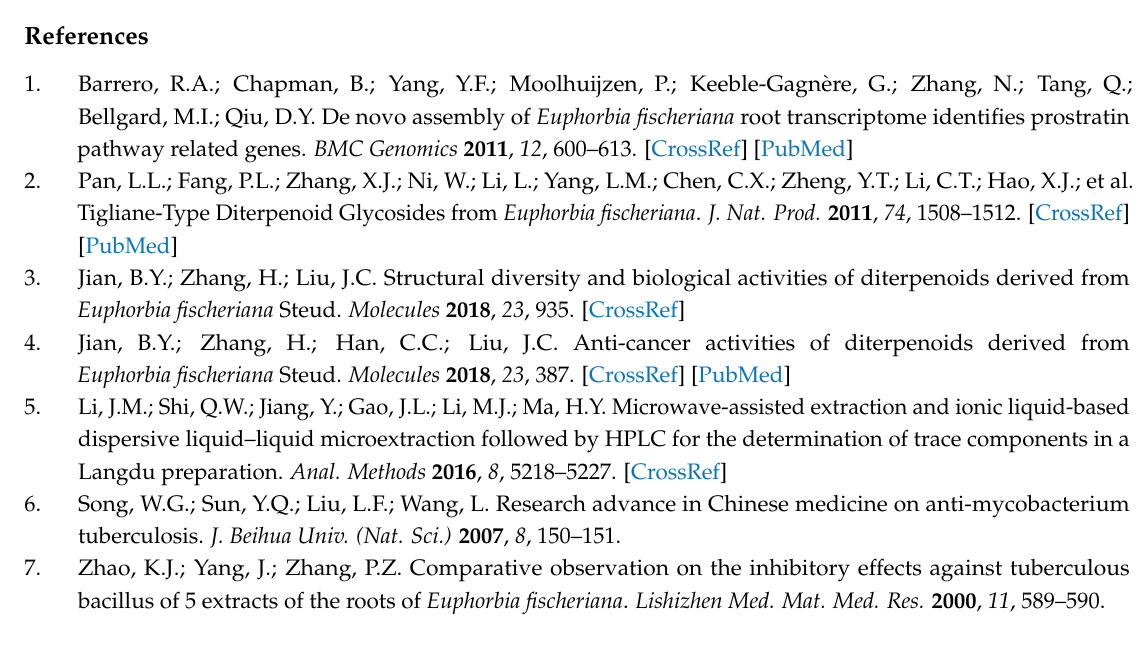
Supplementary Materials: The following are available online, Figure S1: UHPLC chromatogram and calibration curve of ECB, Figure S2: The permeability device, Figure S3: The 1 H-NMR Spectrum of compound ECB, Figure S4: The 13 C-NMR Spectrum of compound